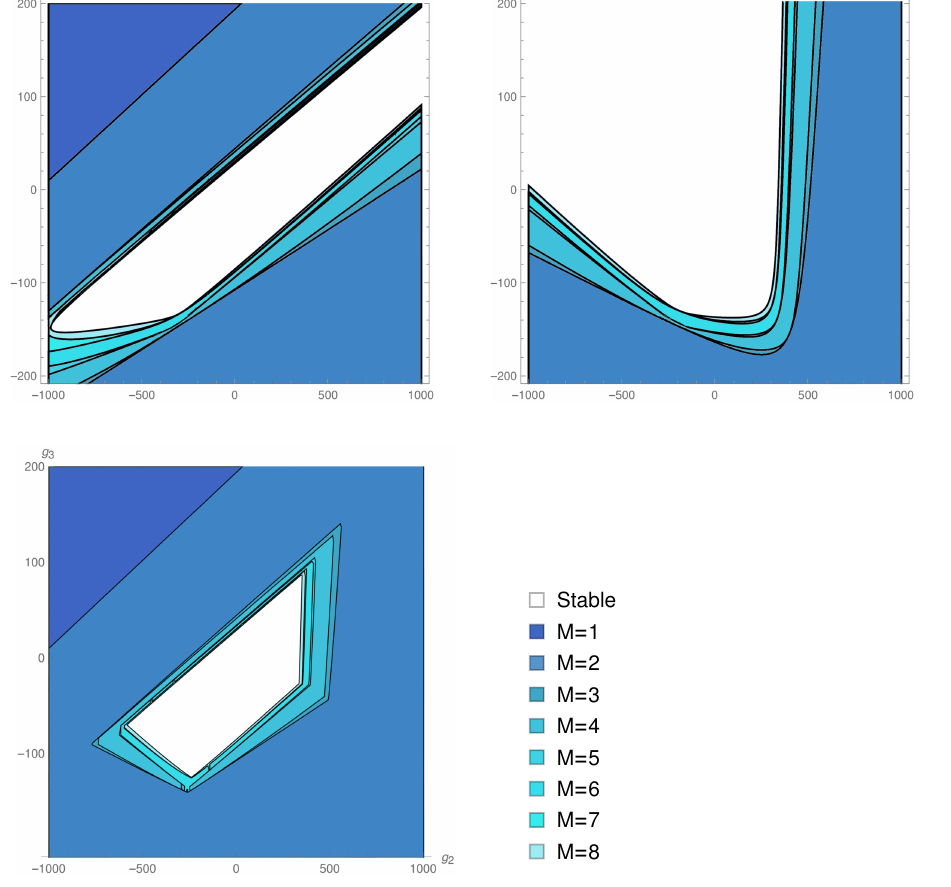
Figure 1 . Construction of the unstable regions in the coupling plane g 2 - g 3 . The plots on the top correspond to the unstable regions in equation (3.8) (left) and (3.9) (right). The plot on the bottom combines both equations. The colors denote the order M of the first negative